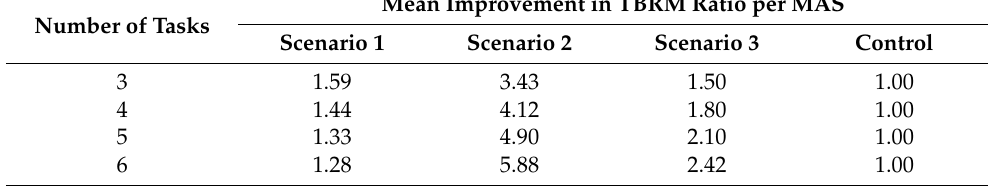
Table 11. Mean results from each scenario in comparison with the control group with respect to the number of tasks in each MAS.